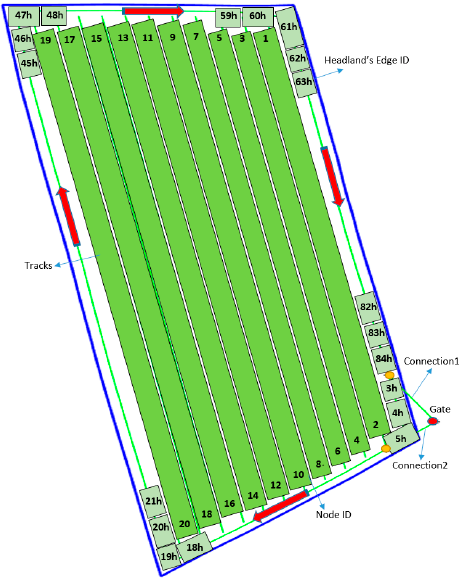
Figure 9. Field partition for the case study field.